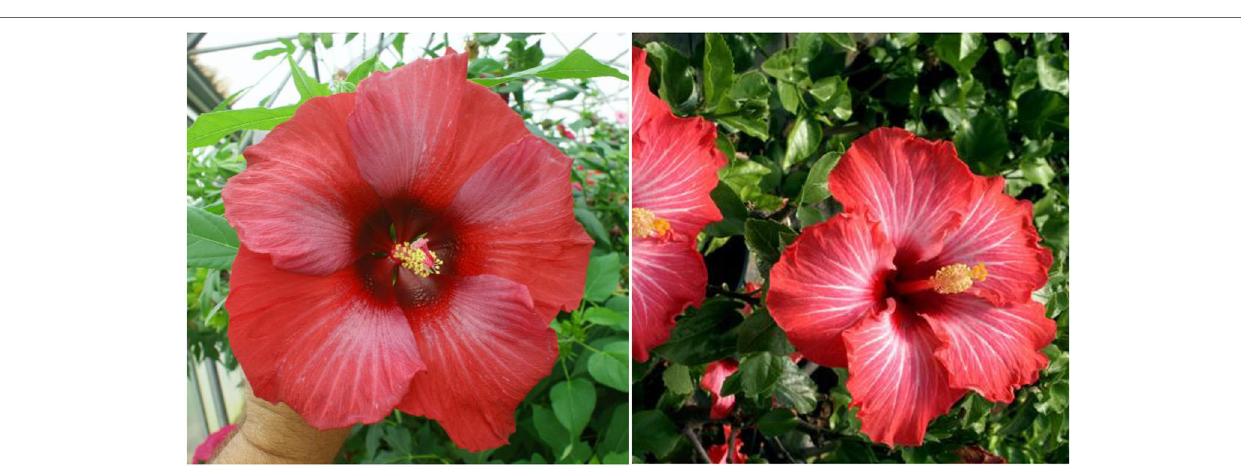
FIGURe 5 | Flower color and shape of H. x moscheutos hybrid “14214-3” (left) and H. rosa-sinensis “Glitz ‘n’ Glitter” (right). Photo credits: Dariusz P. Malinowski (“14214-3”) and Cindy Black (“Glitz ‘n’ Glitter”), Hidden Valley Hibiscus. Used with permission.